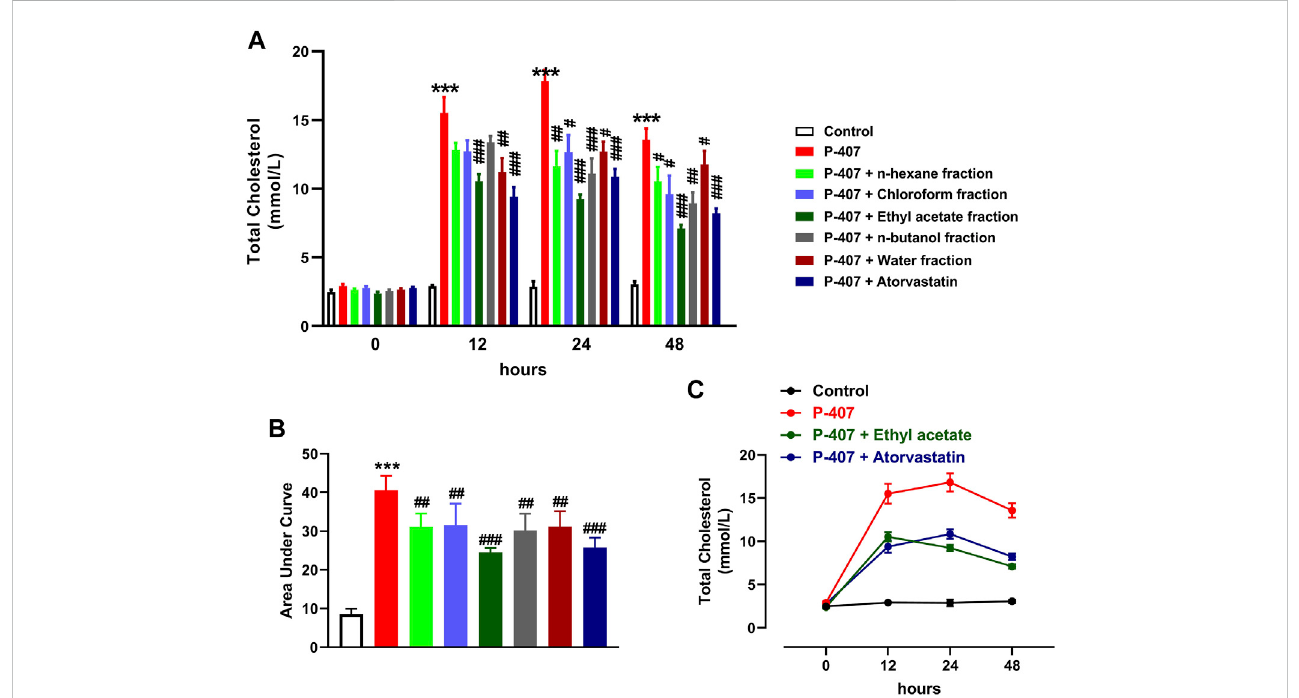
FIGURE 6 Effect of different fractions of MEACL on TC levels at 0, 12, 24, and 48 h (A, B) . Changes in TC levels in control, hyperlipidemic and hyperlipidemic rats treated with ethyl acetate fraction or atorvastatin (C) . Values are represented as mean ± SEM ( n = 6). *** p < 0.001 versus Control, and # p < 0.05, ## p < 0.01, and ### p < 0.001 versus